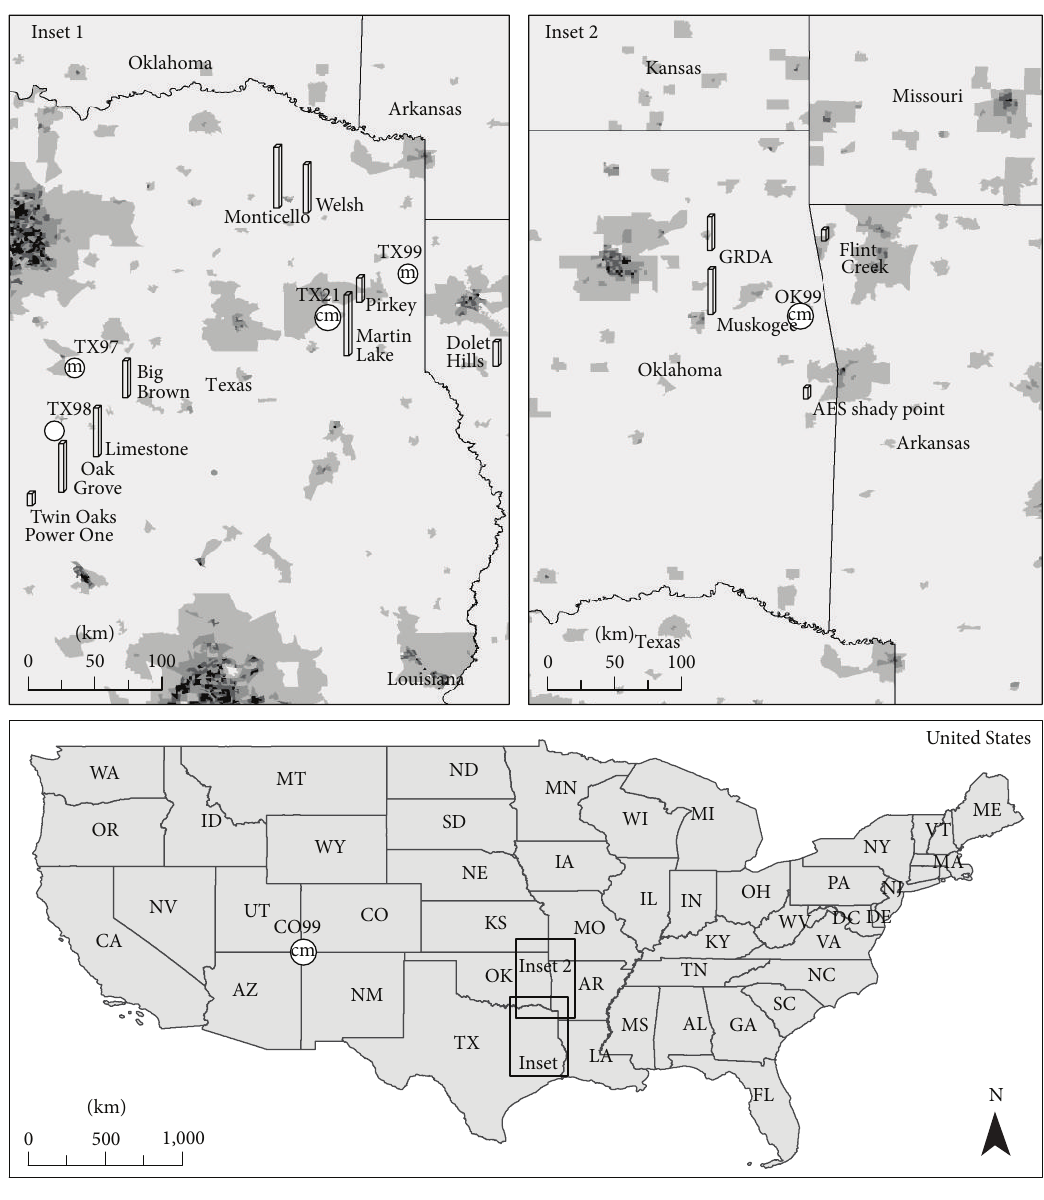
Figure 1: Monitoring sites for the September 27, 2011, to September 25, 2012, Texas/Eastern Oklahoma GOM Dry Deposition Monitoring Study and locations of coal-fired power plants (bottom of bars) within 100 km of the mercury deposition monitoring sites with coal-generated electricity capacity greater than or equal to 100 megawatts (MW). The Mesa Verde National Park site in the Four Corners area (CO99) is included for study comparison